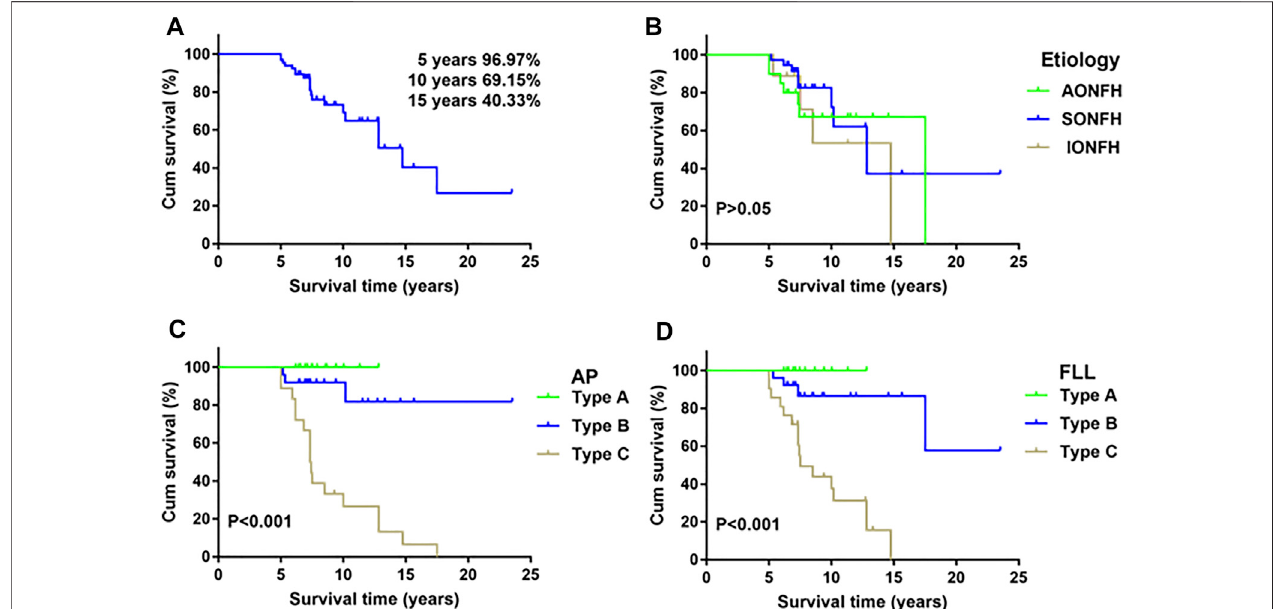
FIGURE 6 | Kaplan – Meier survivorship curve. (A) The cumulative rates of survival (with 95% con fi dence intervals) are 96.97% at 5 years, 69.15% at 10 years, and 40.33% at 15 years with collapse of the femoral head as the endpoint. (B) Survival rates according to etiology. There were no differences ( p (cid:1) 0.56, log-rank test) in survival among etiology. (C) The log-rank test showed longer durations ( p < 0.001) of survival for femoral heads with type A or type B necrotic lesions both in AP radiographs thanfor femoral heads withtype Cnecroticlesions. (D) Thelog-ranktestshowed longerdurations( p < 0.001) ofsurvivalfor femoral heads withtype A or type B necrotic lesions both in FLL radiographs than for femoral heads with type C necrotic lesions.